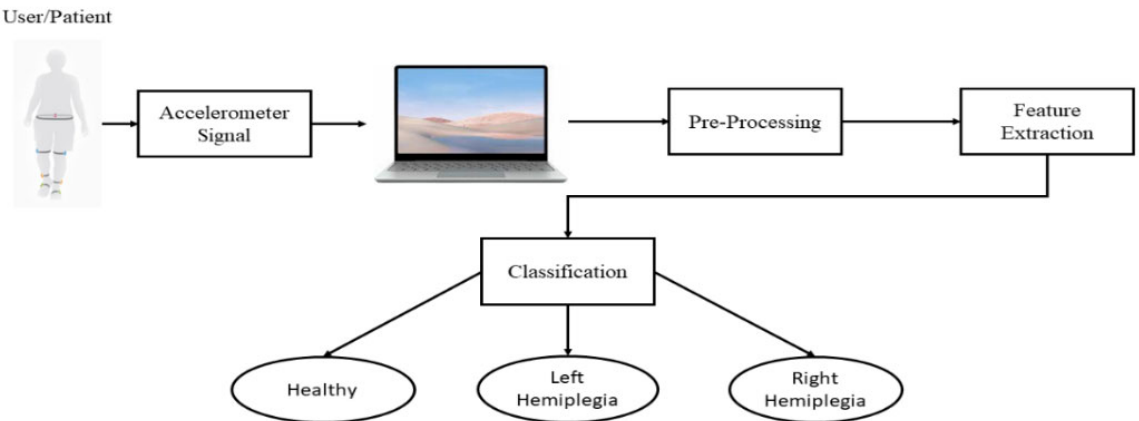
Figure 2. The system architecture. The system receives the accelerometer signals from seven sensors placed in various body parts, which undergo a pre-processing and feature extraction procedure. Then, the extracted features are sent as input to a neural network trained with the LM-BP algorithm responsible for their classification into three classes (healthy, left, or right